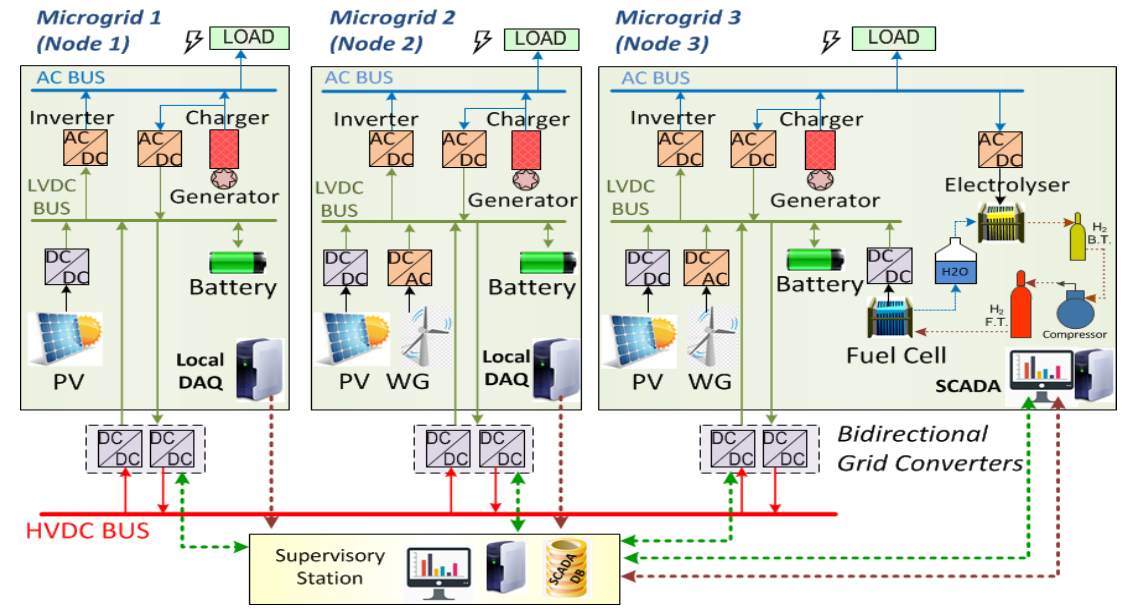
Figure 1. Topology of the autonomous microgrid.